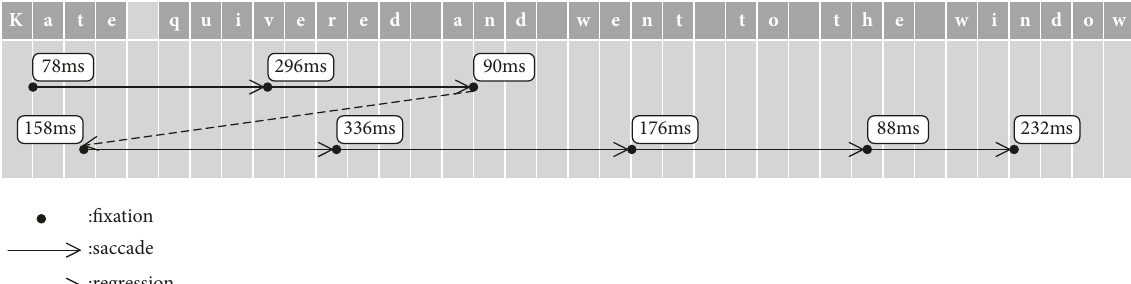
Figure 1: Eye track of an adult reader. Black dots indicate the position of the gaze point, the number next to each dot indicates the duration of each gaze point (in ms), and the arrow indicates the direction of the